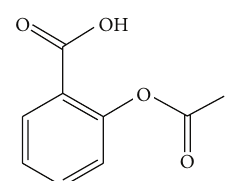
Figure 1: Chemical structure of Aspirin.